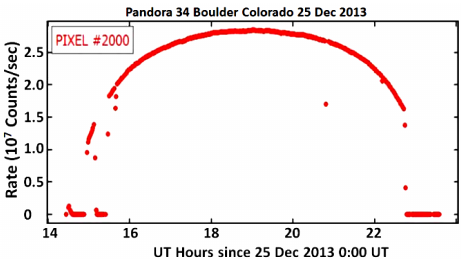
Figure 11. Pixel 2000 (about 520nm) in counts per second vs. time of day (UT) for a clear day (Wednesday 25 December 2013).